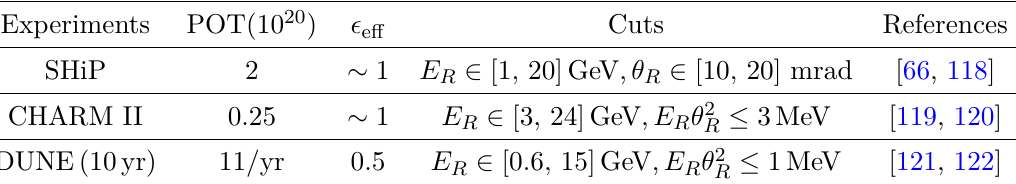
Table 1 . Summary of the main characteristics of the experiments that we considered. Here E R and θ R are the recoil energy and the recoil angle with respect to the incoming neutrino’s momentum of the scattered electrons, while (cid:15) is the detection efficiency of the eff